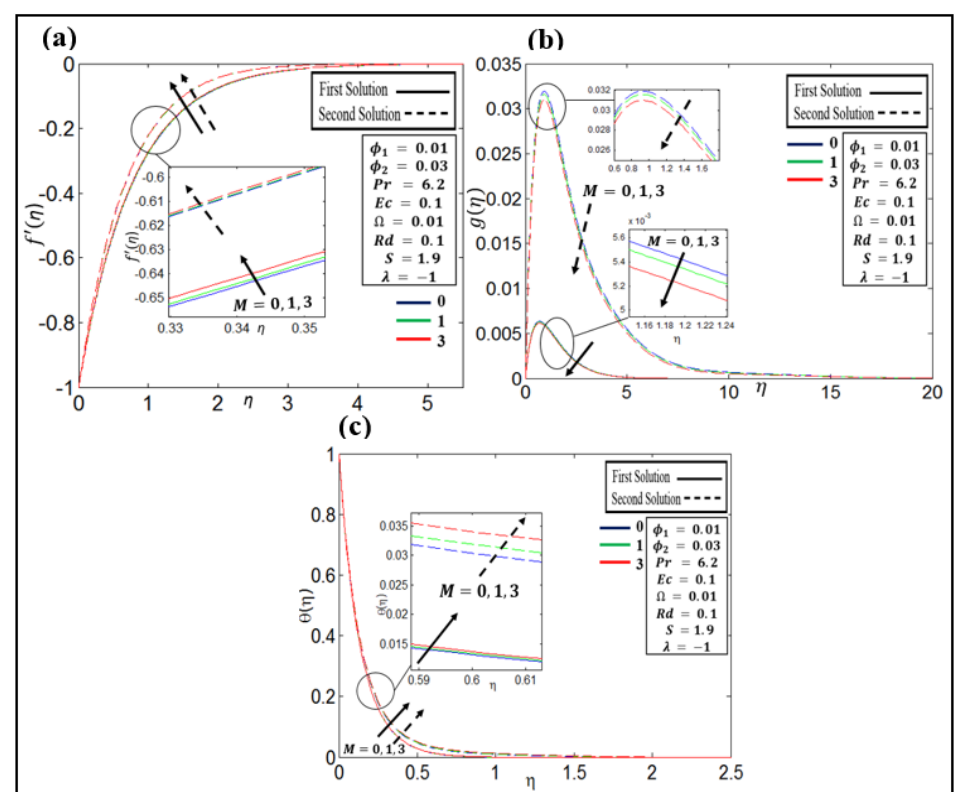
Figure 4. ( a – c ) Profiles of velocity 𝑓′(𝜂) , 𝑔(𝜂) , and temperature 𝜃(𝜂) for different 𝑀 . The plots of the velocity profile ( f (cid:48) ( η ) , g ( η )) and the temperature profile θ ( η ) against solid nanoparticle volume fractions φ 2 = 0.02, 0.04, and 0.06 of copper are portrayed in